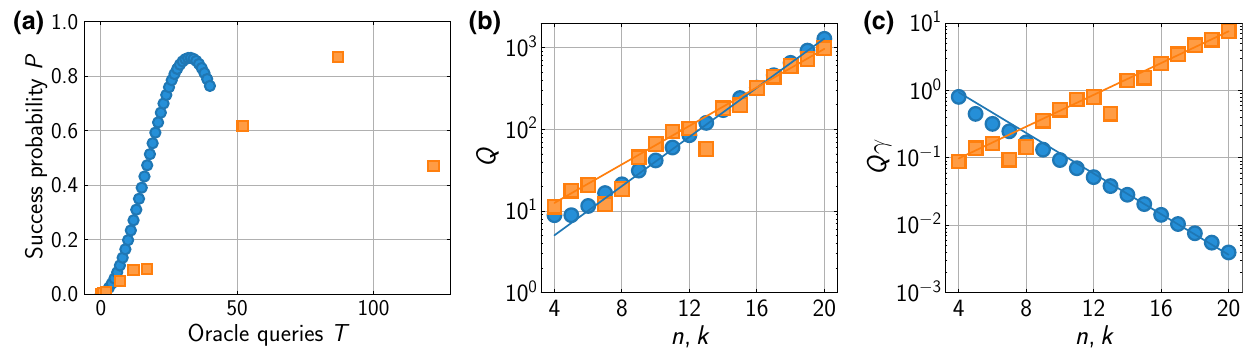
FIG. 11. Comparison of the standard (blue circles) and recursive (orange squares) algorithms. (a) Success probability P versus number of oracle queries T for a single instance of number partitioning at n = k = 12. Recursive algorithm is performed with m = 4 and γ = 2 − m − 1 . The physical time per query (at fixed J max ) is longer by a factor of 2 k − m − 1 = 2 7 for the standard algorithm than for the recursive algorithm. (b) Median speedup [ Q ] in query complexity, plotted versus n = k for the standard algorithm with γ = γ c 0.5 and the recursive algorithm with m = 6 and γ = 2 − m − 1 . Lines denote the 2 0.5 n scaling for the standard algorithm and 2 ( 0.5 − 0.65 / m ) n γ in physical runtime at fixed J = k for the standard algorithm scaling for the recursive algorithm. (c) Speedup [ Q ] max , plotted vs. n 0.5 with γ = γ c and the recursive algorithm with m = 6 and γ = 2 − m − 1 . Lines denote the 2 − 0.5 n scaling for the standard algorithm and 2 ( 0.5 − 0.65 / m ) n scaling for the recursive algorithm.